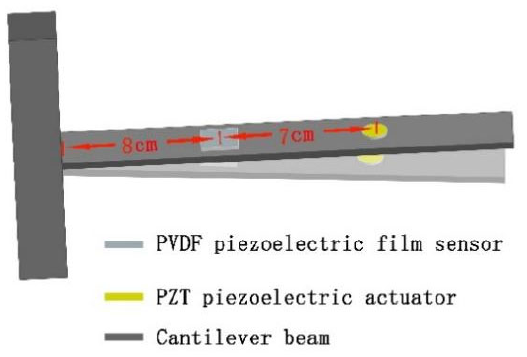
Figure 2. Schematic diagram of a cantilever beam structure.